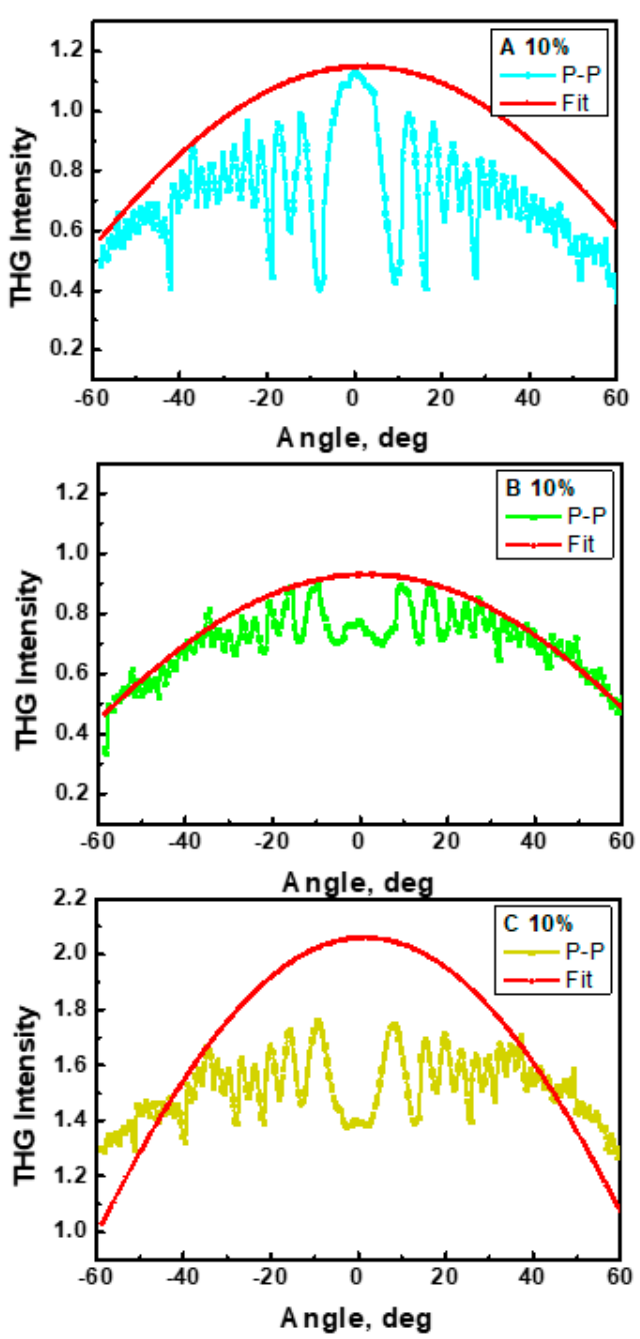
Figure 14. THG intensity as a function of incident angle of A/PVK, B/PVK, and C/PVK composites with 10 wt% of chromophores in p-p polarization.